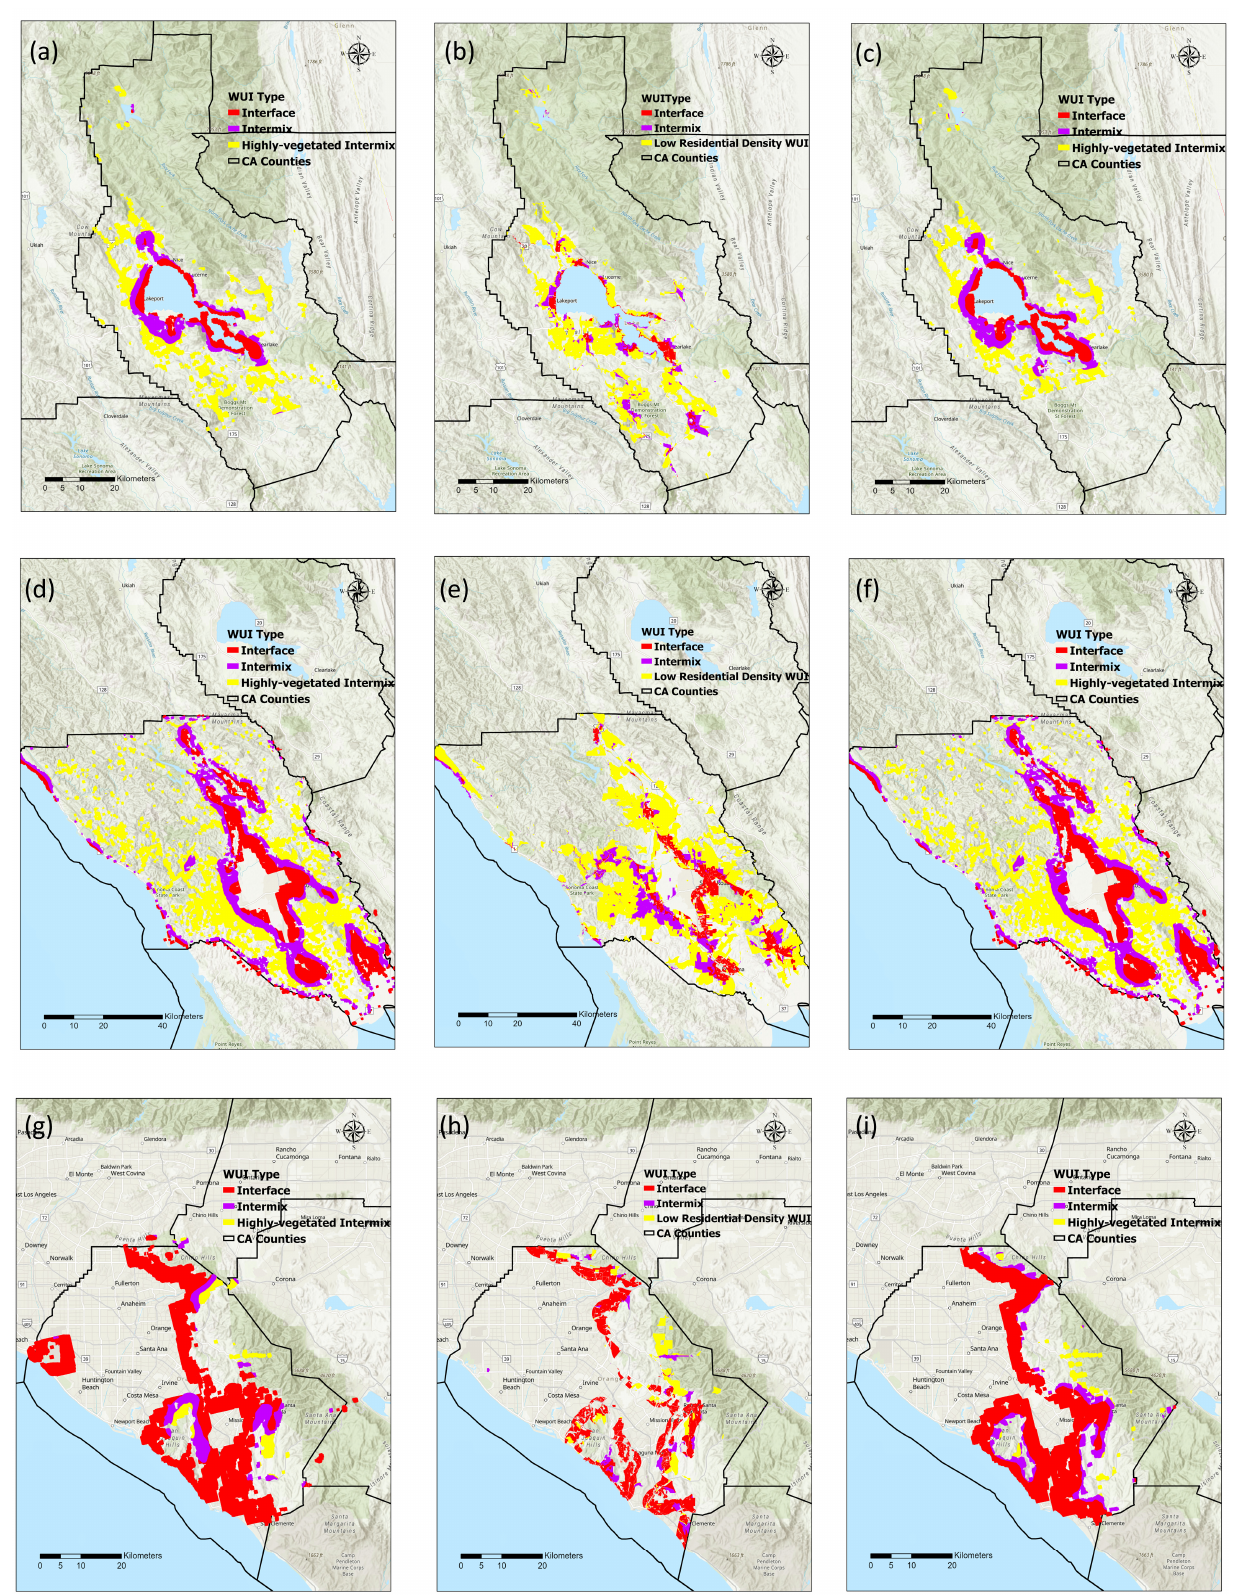
Figure 8. Comparison of WUI maps derived from the 2010 NAIP-based building footprints in this study ( a , d , g ); from SILVIS 2010 WUI maps ( b , e , h ); and from the 2018 Microsoft building dataset ( c , f , i ). Results are shown over Lake County ( top ), Sonoma County ( middle ), and Orange County (bottom